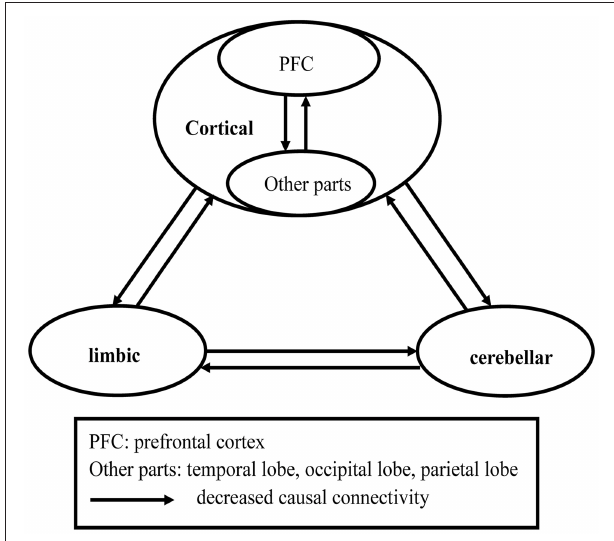
FIGURE 1 | Hypothesized model in first-episode, drug-naive somatization disorder: overall reduced causal connectivities in the cortico-limbic-cerebellar